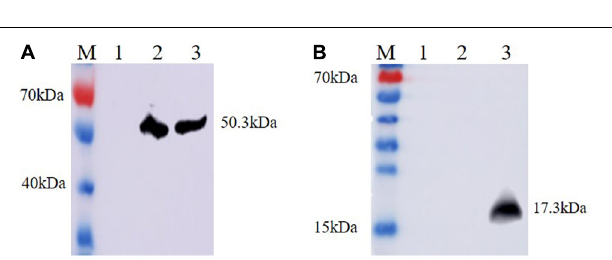
FIGURE 3 | Analysis of Ts-ADpsp and Ts-ADpsp-IL-4 proteins expression by western blotting. Ts-ADpsp and Ts-ADpsp-IL-4 proteins were detected by western blotting using anti-Flag (A) and anti-His (B) monoclonal antibodies as primary antibodies and HRP-conjugated goat anti-mouse IgG as the secondary antibody. M: protein molecular weight marker; lane 1: pValac/pSIP409 plasmid; lanes 2: pValac-Ts-ADpsp/pSIP409 plasmid and 3: pValac-Ts-ADpsp-IL4/pSIP409-FnBPA plasmid expressed in HEK-293T cells, respectively.